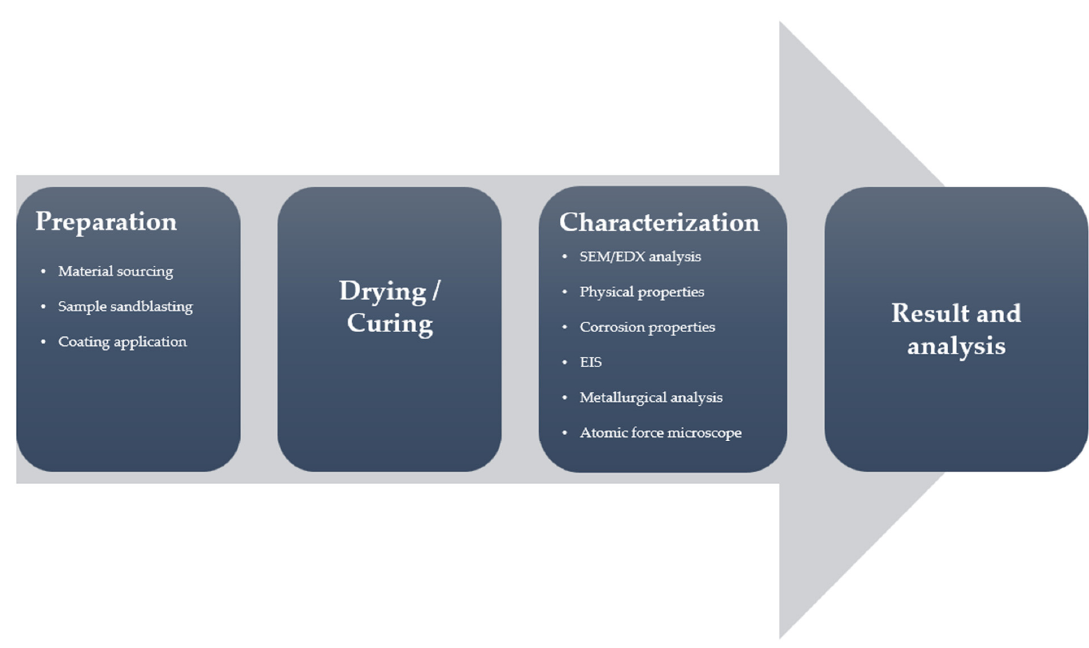
Figure 4. Flow diagram of the methods and procedures used in this study.